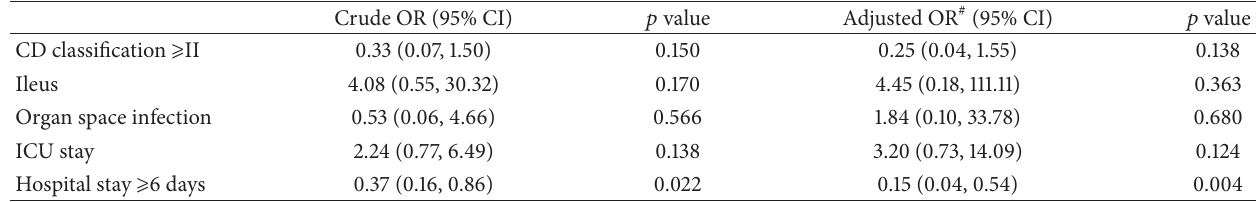
Table 4: Logistic regression analysis of surgical outcomes between laparoscopic and open group with associated